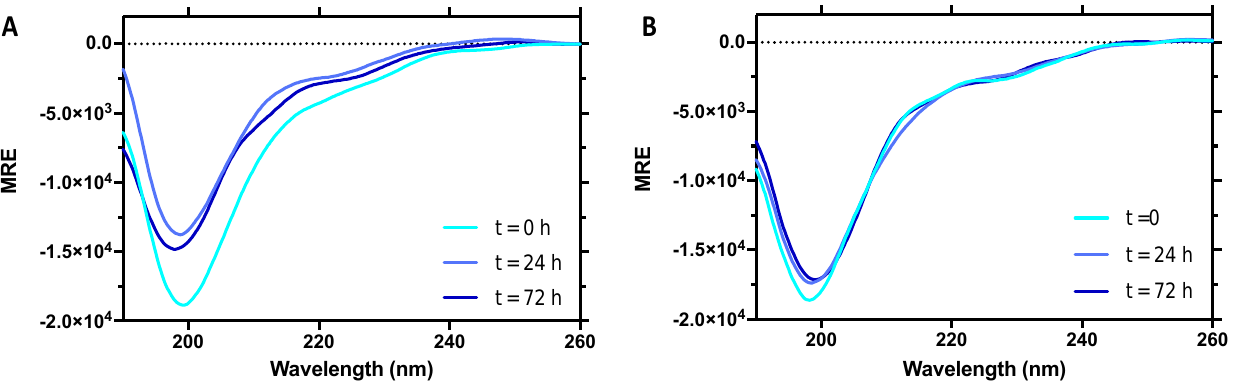
Figure 5. Far-UV circular dichroism (CD) studies of PNT3 ( A ) and PNT3 3A ( B ). The spectra were recorded in 10 mM sodium phosphate pH 6.5 at 37 ◦ C. Protein concentration was at 0.06 mg mL − 1 (4 µ M). The spectra shown in cyan correspond to a freshly purified PNT3 or PNT3 3A sample recorded immediately after elution from the SEC column. The spectra shown in light and dark blue were recorded from the same samples incubated at 37 ◦ C for 24 h and 72 h, respectively. Note the much more pronounced decrease in the signal for the spectrum at 24 h of PNT3 compared to PNT3 3A . MRE (Θ) is expressed in deg cm 2 dmol −1 .